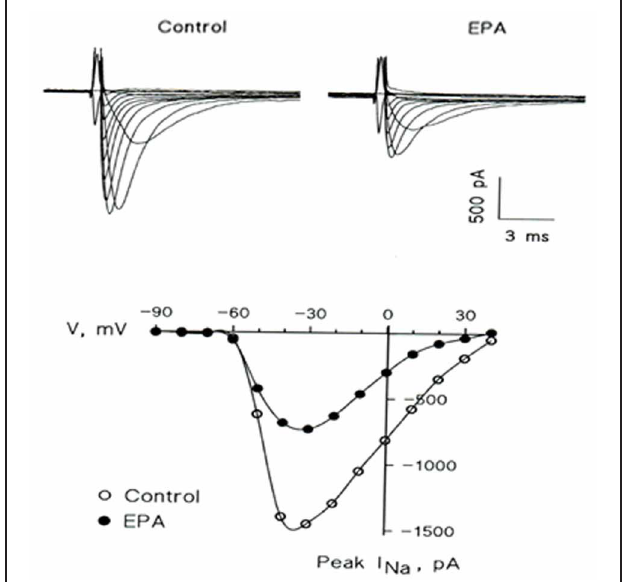
FIGURE 4 | EPA suppresses the voltage-activated Na + current ( I Na ) in a representative cultured neonatal rat ventricular myocyte. (Upper) Superimposed traces in the absence (Control) and presence (EPA) of 5 µ M EPA. The currents were elicited by 10mV increment voltage steps (20ms; 0.2Hz) from a holding potential of − 80mV down to − 90mV and up to 40mV. (Lower) Current-voltage relations of peak I Na in the absence ( ◦ ) and presence ( • ) of 5 µ M